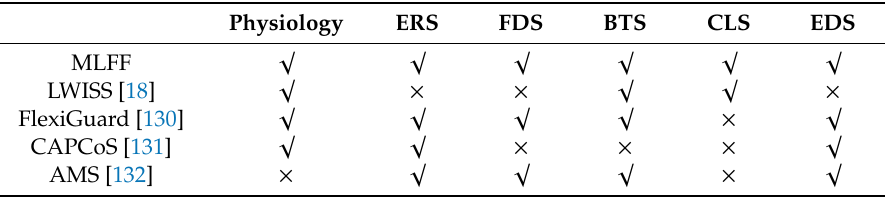
Table 6. Comparison between the MLFF and existing